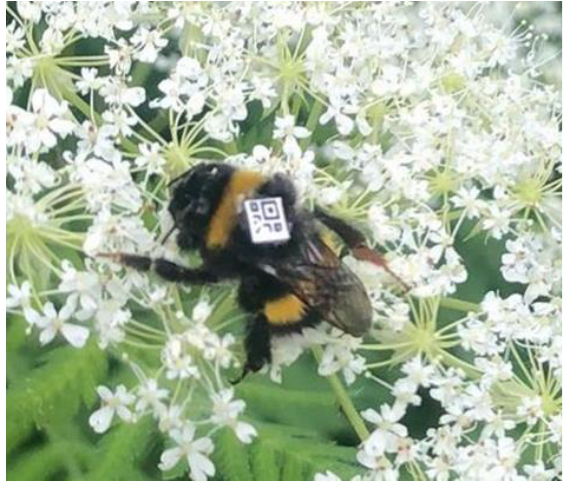
Figure 3. Bumblebee worker marked with bCode foraging on Anthriscus sylvestris flowers in Urtehagen at University of Oslo (approx. 50 metres from the monitoring stations and colony boxes). Note that the bCode recognition software was able to correctly recognize and identify the tag. Photo: Malin R. Aarønes. Date 29 May 2019 6 colonies of which 2 acted as control (0 µg/L), 2 received low concentration (6.5 µg/L) and 2 received the high concentration (10.2 µg/L) of clothianidin. The selected concentrations were within field-realistic concentrations, based on quantified residuals of clothianidin in leaves, nectar and pollen (Xu et al. 2015; Mogren et al.2016; Botías et al.